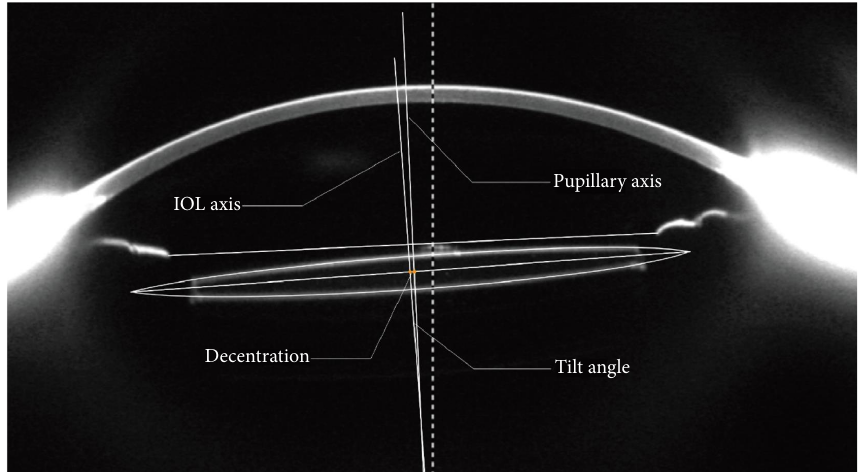
Figure 2: Scheimpfug analysis of intraocular lens (IOL) position. Te tilt angle was defned as the angle between two axes. Te decentration was calculated as the distance between the IOL axis and the pupillary